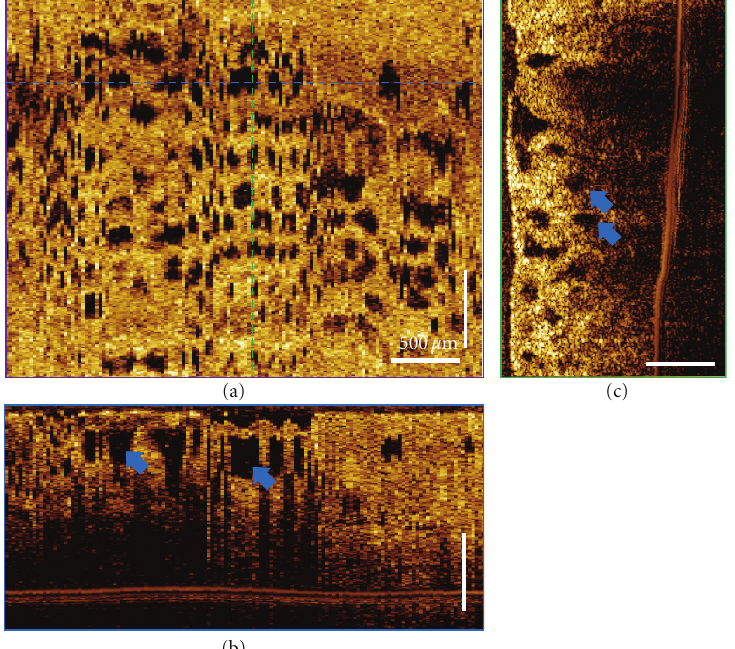
Figure 6: Magnified orthoplanes of the treated area showing the spongiform appearance due to the edematous tissue caused by freezing, as indicated by blue